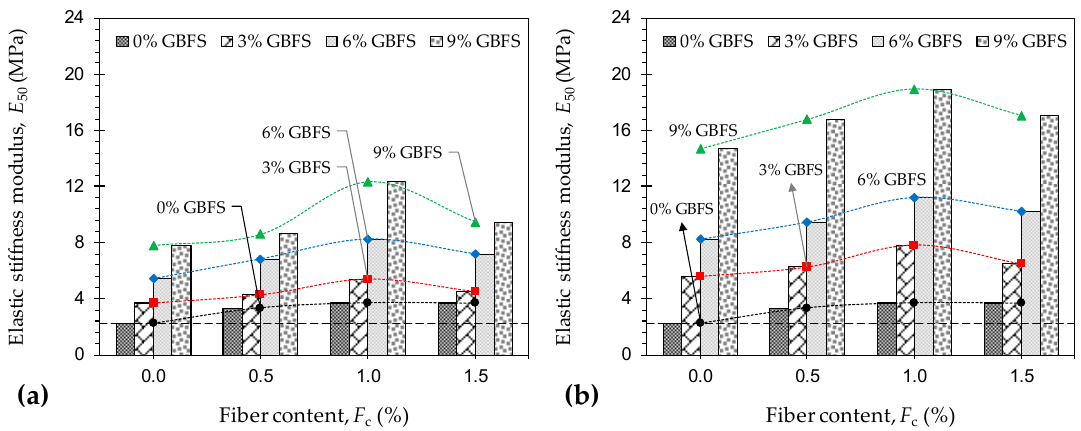
Figure 7. Variations of E 50 against JF content for the natural soil and various GBFS-treated samples: ( a ) T c = 7 days; and ( b ) T c = 28 days.